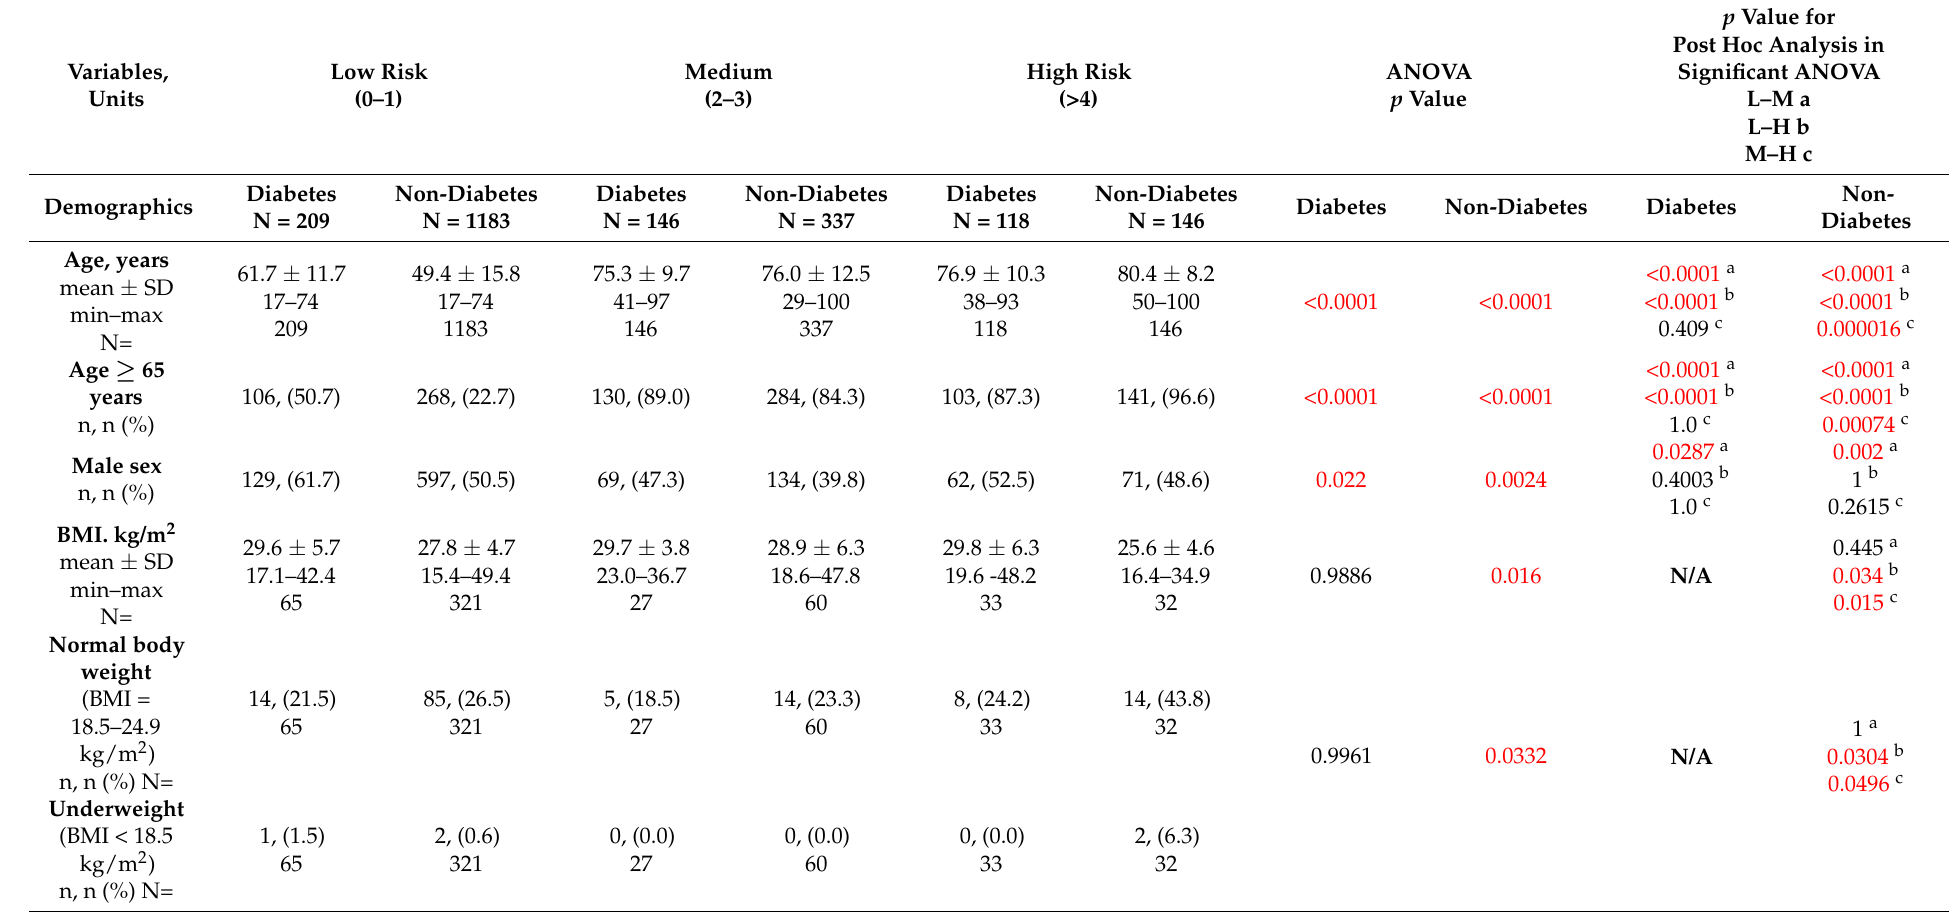
Table 1. Baseline demographics, clinical characteristics, and comorbidities in the diabetic and non-diabetic